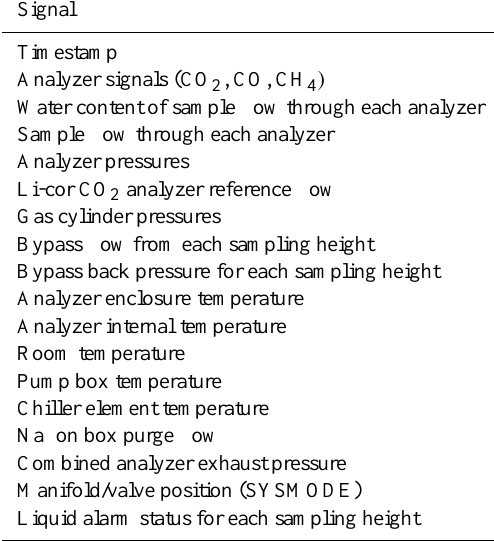
Table A1. Signal list.